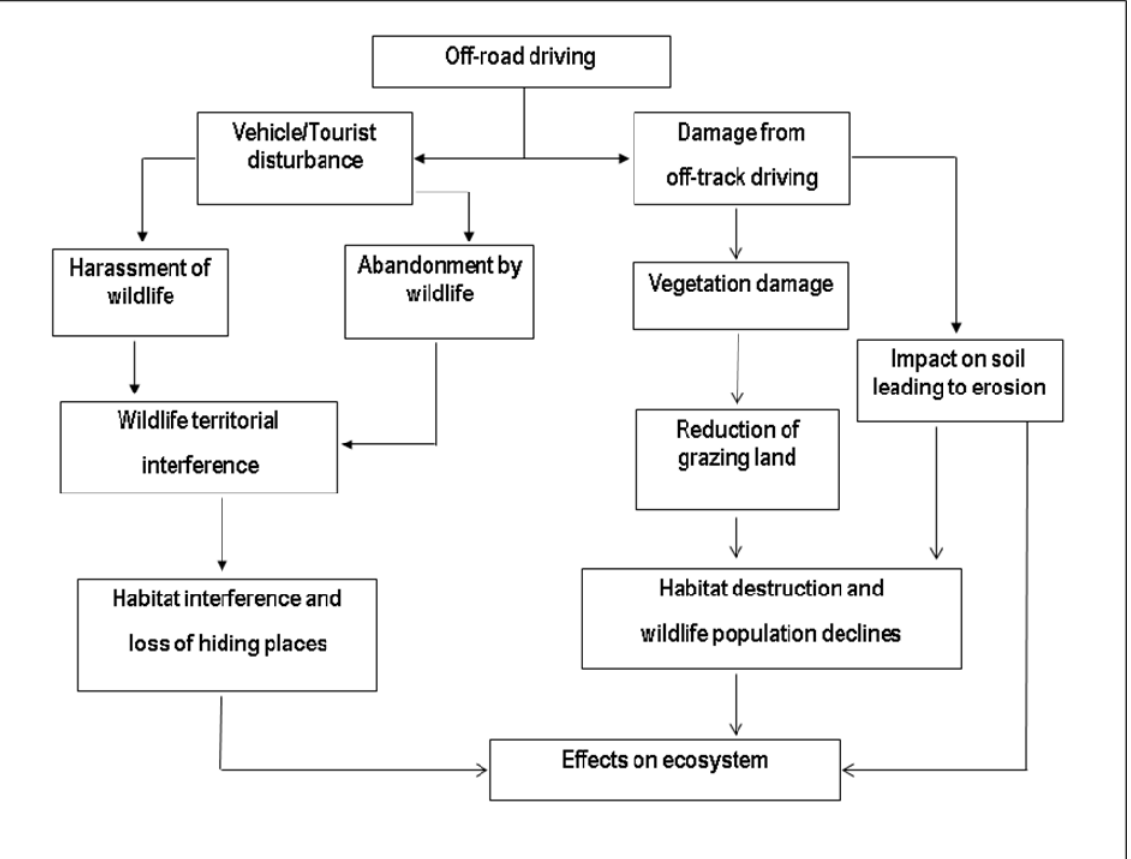
Figure 10. Effects of off road driving in the Masai Mara National Reserve and surrounding